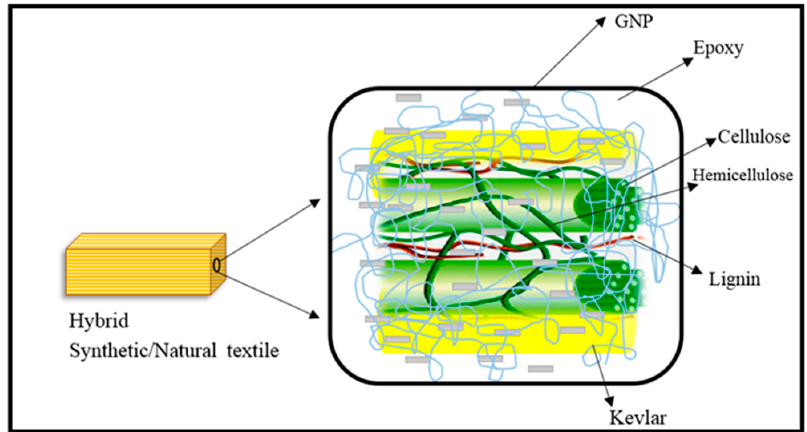
Figure 3. Schematic of different constituents of hybrid composites.